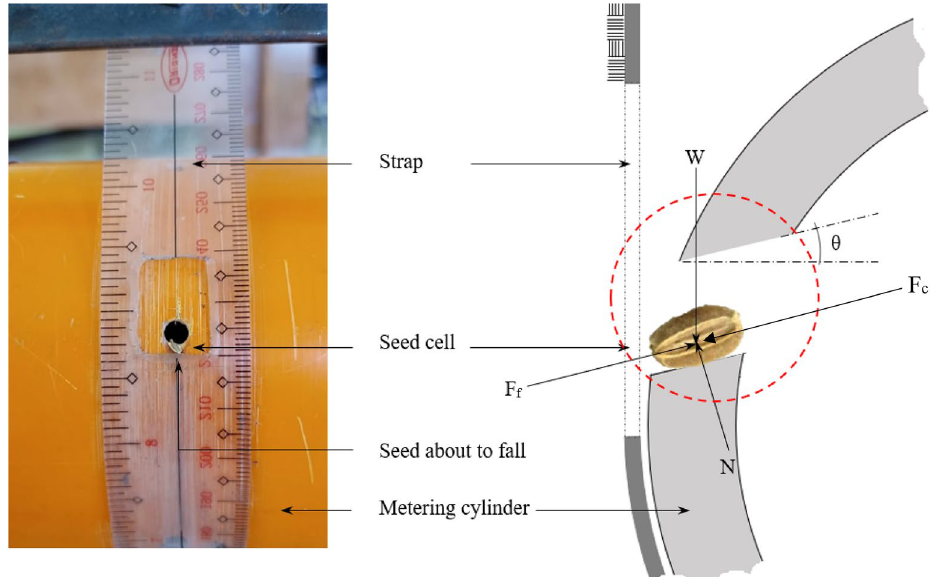
Figure 2. Schematic diagram of the fabricated metering cylinder showing the seed cell focusing on the seed that is about to fall out of the seed cell at the discharge point and the accompanying forces acting on the seed; W, the weight of the carrot seed; N, the normal force acting perpendicular to the inclination, and F f , the frictional force of the seed to the metering